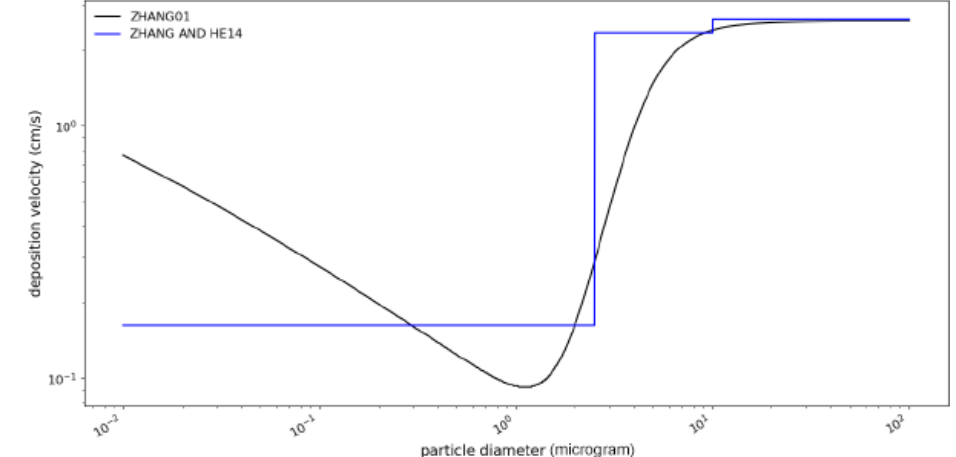
Figure 2. Dry deposition velocity over a desertic surface, as a function of particle size, parameterised by the Zhang et al. (2001) and the Zhang and He (2014) schemes.